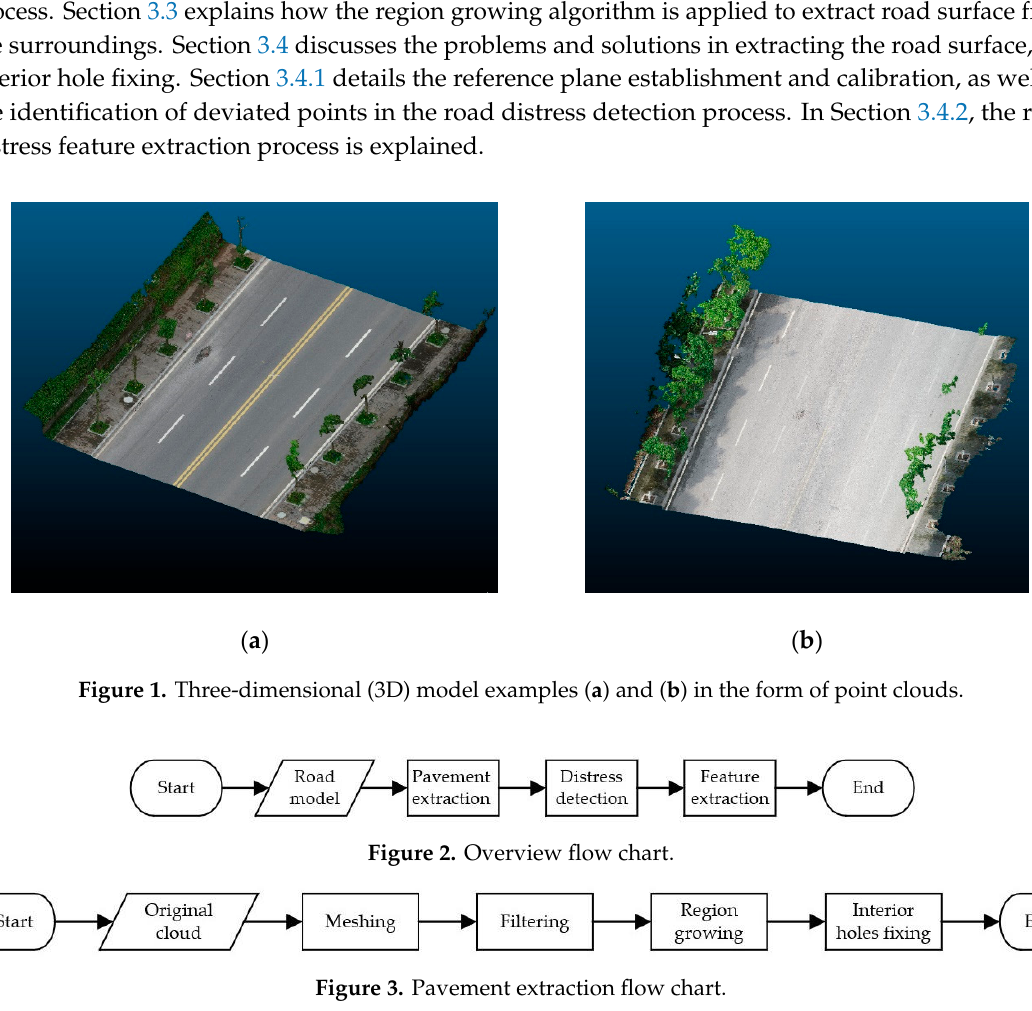
Figure 3. Pavement extraction flow chart. Figure 4. Distress detection and feature extraction flow chart.